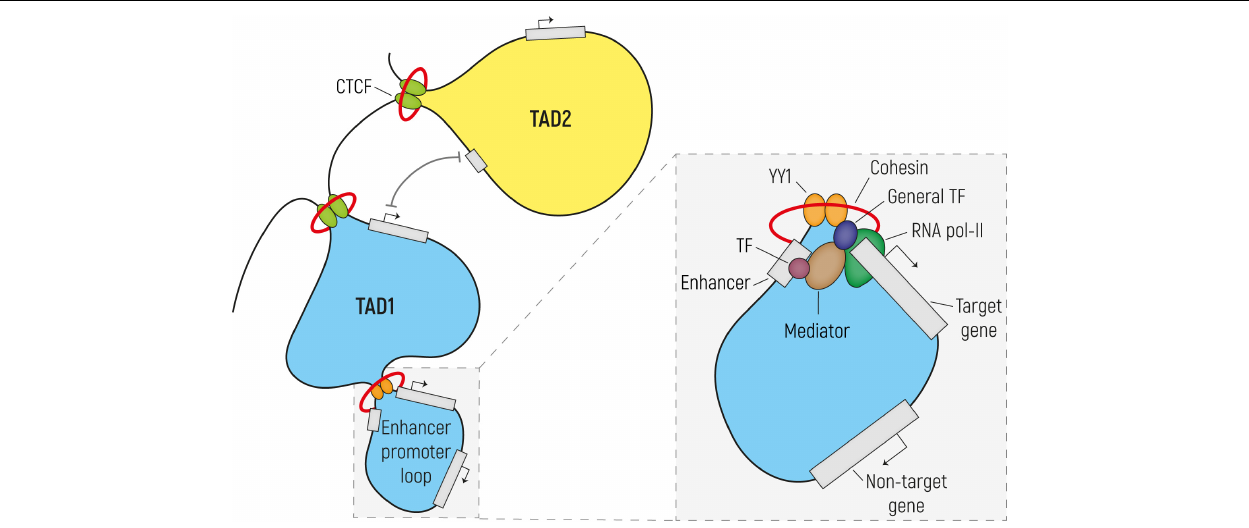
FIGURE 1 | Regulatory enhancer-promoter interactions are restricted within the topological associating domain (TAD) region. The genome (here represented as a black line) is tightly packaged and organized in TADs established by the binding of CTCF to insulator elements, followed by dimerization and interaction with the cohesin complex. In order to establish the enhancer-promoter loops required for transcriptional regulation, enhancers and their target gene should reside in the same TAD. These regulatory loops are formed by the dimerization of YY1 and its interaction with cohesin. In the enlargement is a simplified scheme of transcription initiation (the size does not reflect the actual dimension of each component). Transcription factors (TFs) bind on the enhancer element while the pre-initiation complex formed by the RNA Pol II and the general TFs assembles at the promoter region. Mediator establishes the connection between enhancer and promoter via interactions with TF and components of the transcription preinitiation complex, without binding to DNA. Mediator regulates the phosphorylation of the RNA Pol II in order to release it from the promoter and start